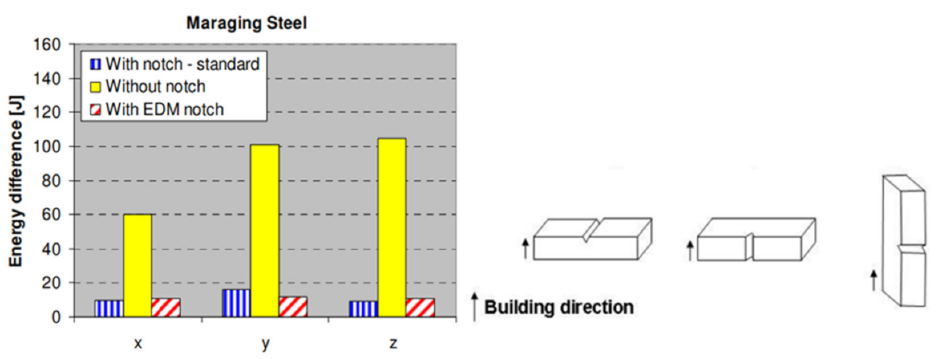
Figure 33. Amount of energy absorption measured by Charpy test on AM